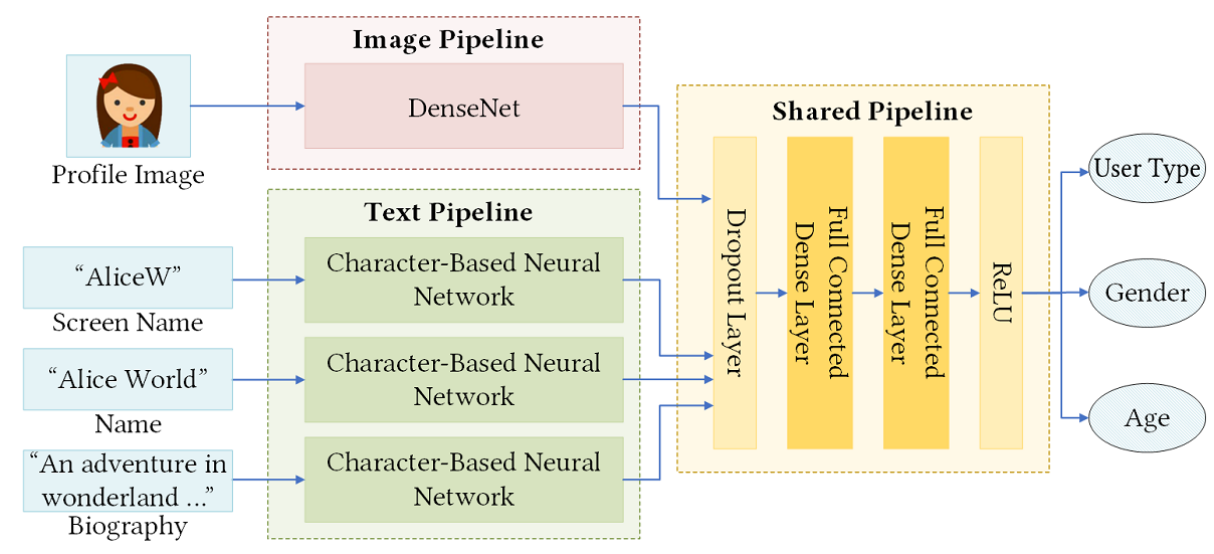
Figure 3. The structure of the M3 (multimodal, multilingual, and multi-attribute) model for inferring user type, gender, and age from profile information. DenseNet: dense convolutional network; ReLU: rectified linear